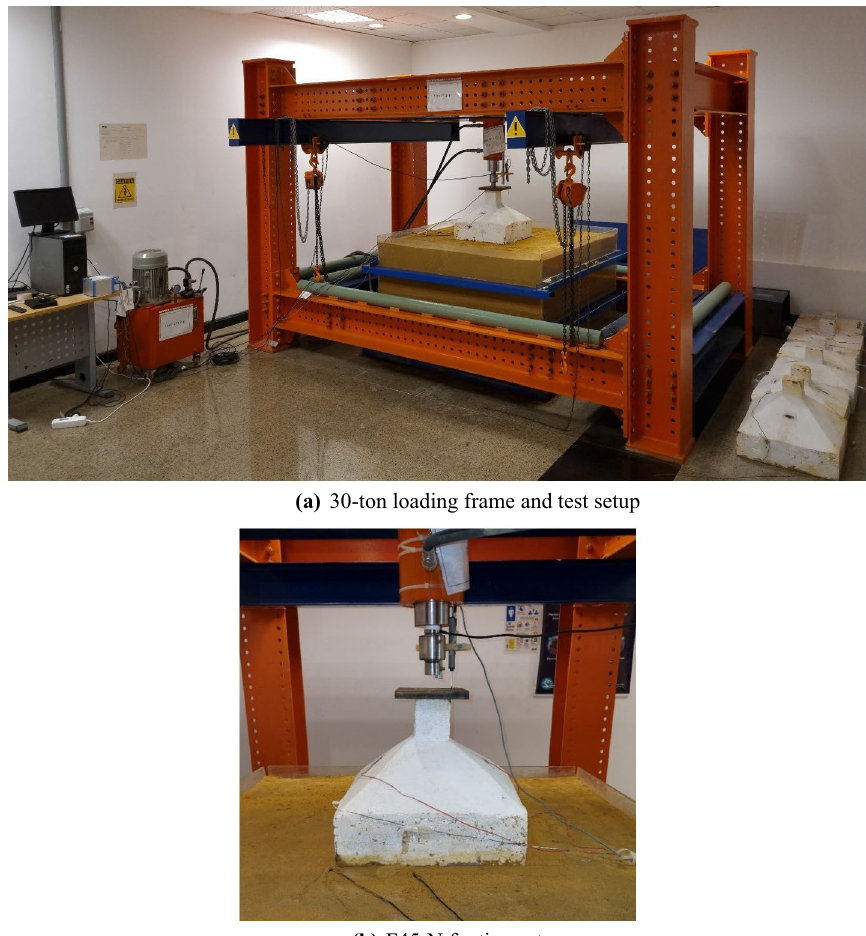
Fig. 11 Experimental test setup ( a ) loading frame, and ( b ) footing under axial